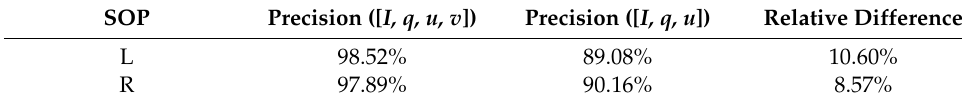
Table 6. Precision of Chattonella marina .